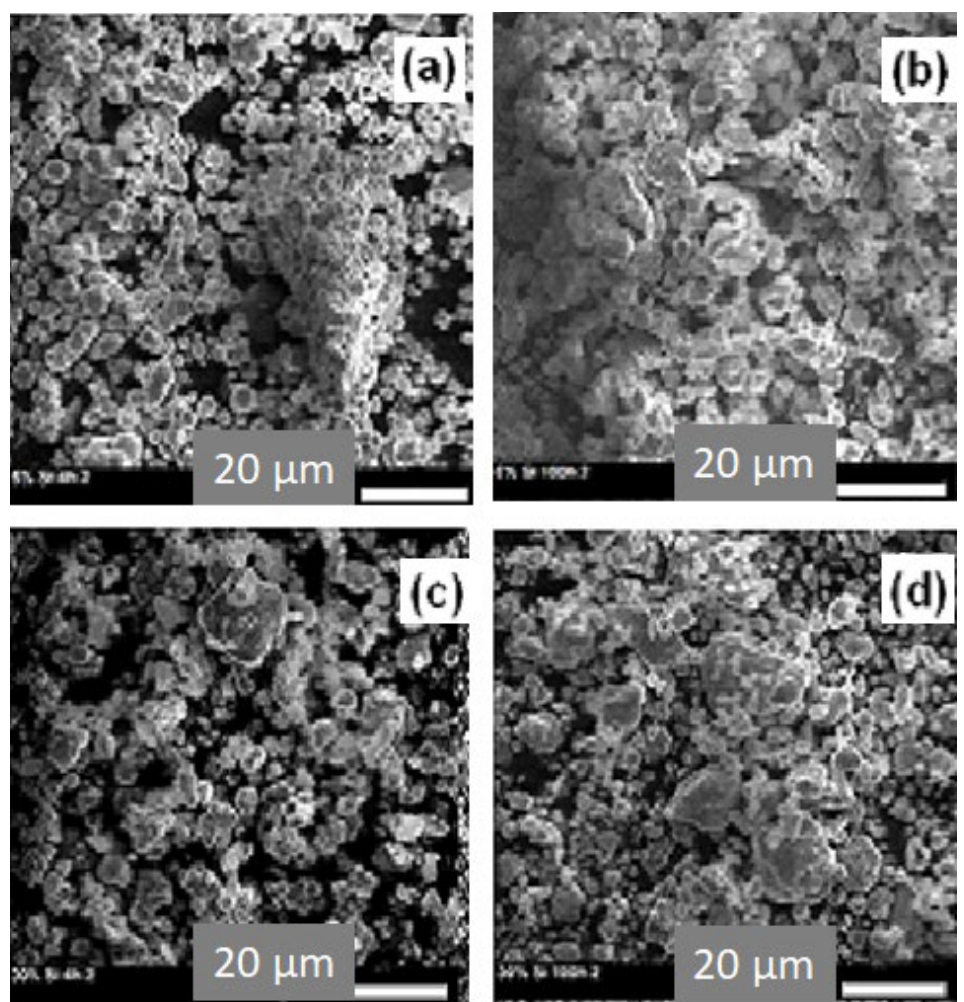
Figure 1. SEM micrographs for powders: Fe 55 Co 25 Ni 15 Si 5 obtained after 4 h ( a ) and after 100 h of milling ( b ) and Fe 30 Co 25 Ni 15 Si 30 milled for 4 h ( c ) and for 100 h ( d ), respectively.